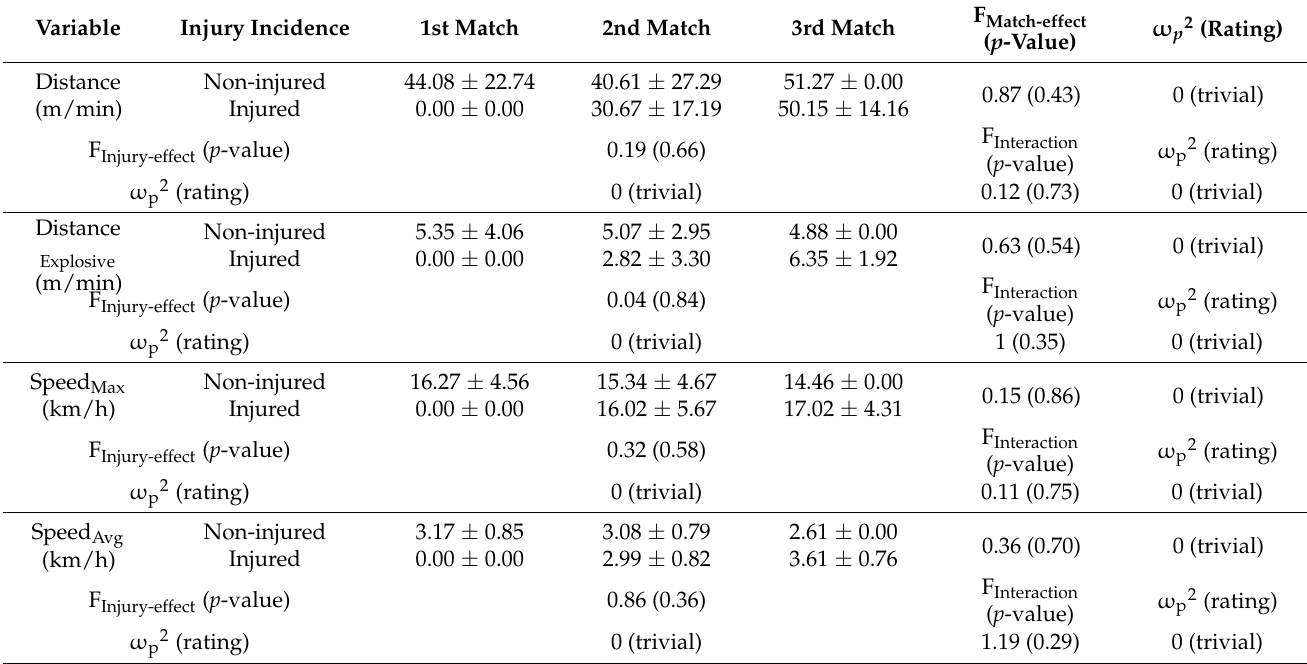
Table 4. Raw data of spatio-temporal workload variables by match and injury incidence.